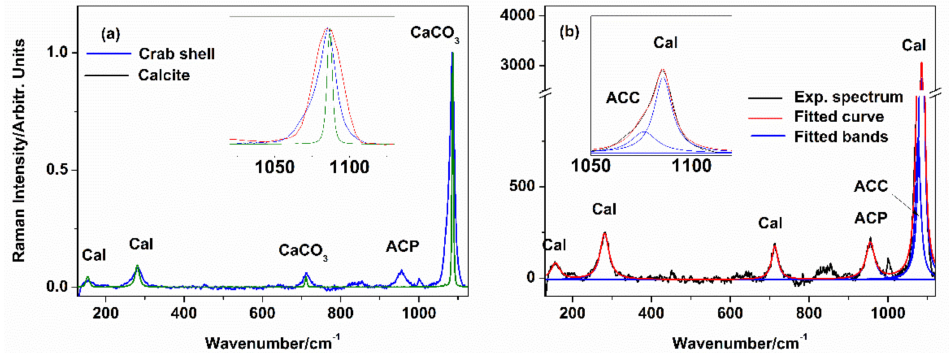
Figure 2. ( a ) Comparative Raman spectra of the bulk blue crab Callinectes sapidus unpigmented shell, and the FT-Raman spectrum of synthetic calcite; insert shows the zoom of 1030 to 1130 cm − 1 range containing the CaCO 3 v 1 (CO 32 − ) band. ( b ) Averaged Raman spectrum (29 spectra, background subtracted) acquired from the white shell areas of the Atlantic blue crab, C. sapidus , and fitted with Lorentzian profiles. Insert shows the zoom of the v 1 (CO 32 − ) band. Band labels of minerals: Cal = calcite; ACC = amorphous calcium carbonate; CaCO 3 = shared bands of calcite and ACC; ACP = amorphous calcium phosphate Excitation: crab shell 532 nm, synthetic calcite 1064